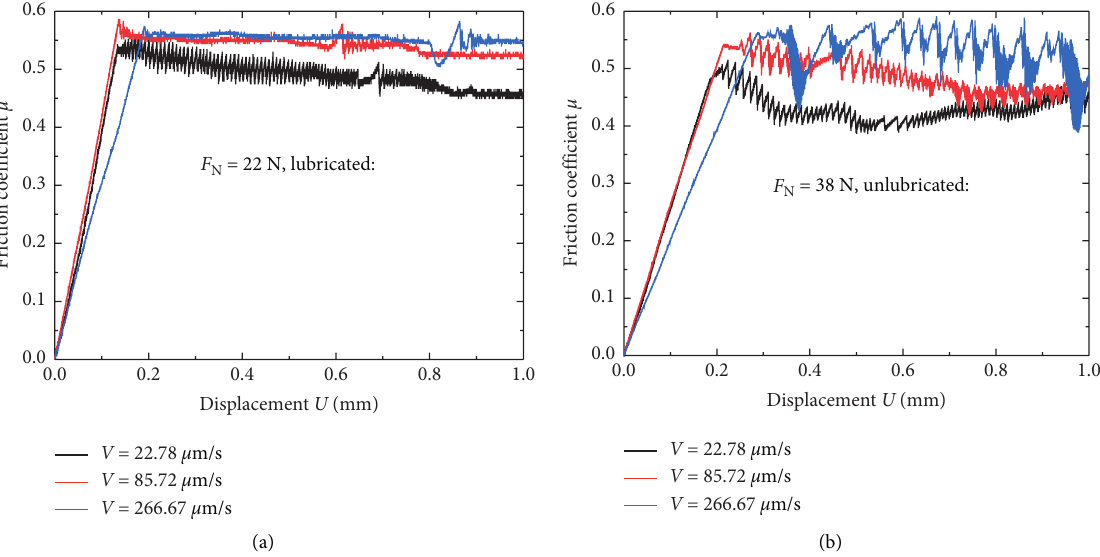
Figure 6: Effect of sliding velocity on the transition from static to kinetic friction.